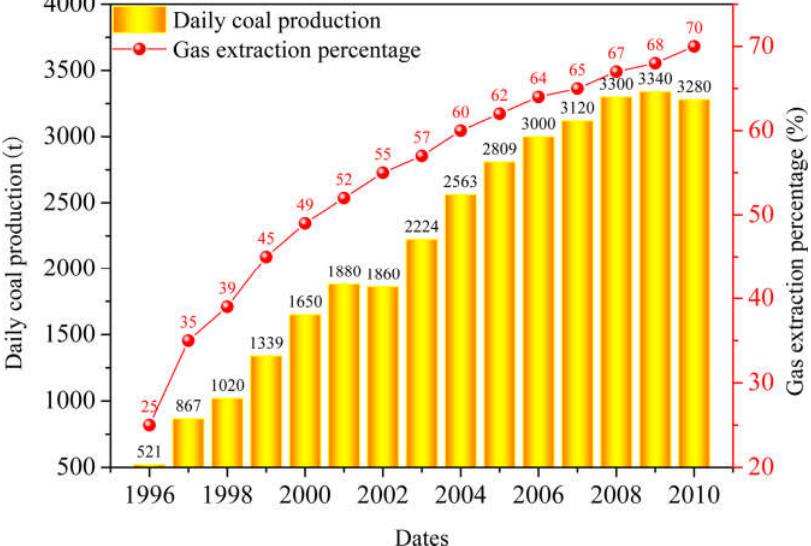
Figure 15. The gas extraction percentage and daily coal production in recent